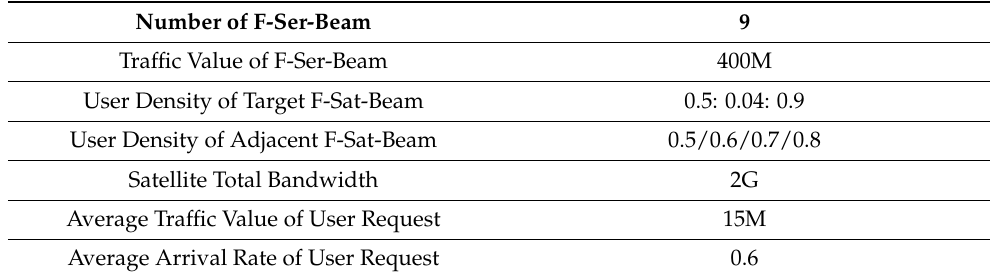
Table 3. Simulation parameters configuration of load